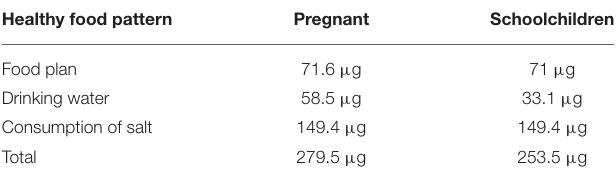
TABLE 4 | Daily iodine intake of pregnant women and schoolchildren considering a healthy eating